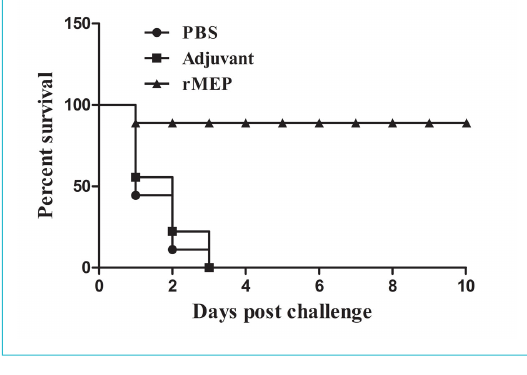
Figure 9: Survival rates of the mice at various time points af- ter A. baumannii challenge (n = 9). Nine mice challenged with A. baumannii were randomly selected for the observation and record- ing of survival everyday up to 10 days after challenge. Data are shown as the percentage survival at each time